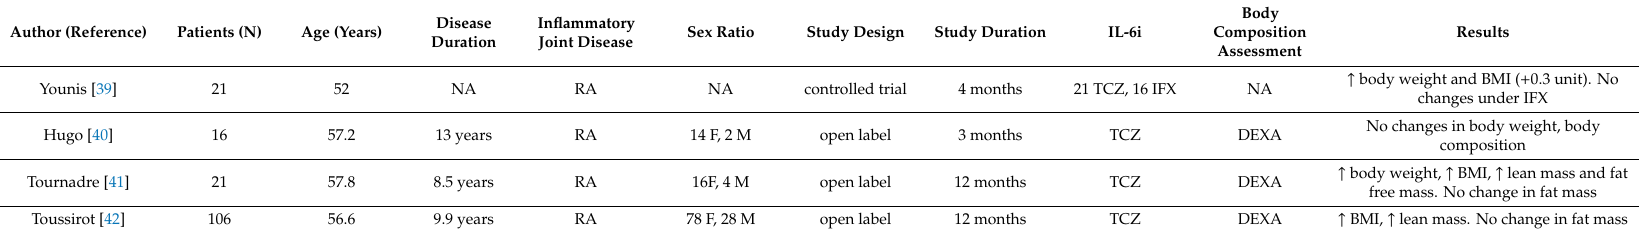
Table 2. Changes in body composition during tocilizumab treatment in rheumatoid